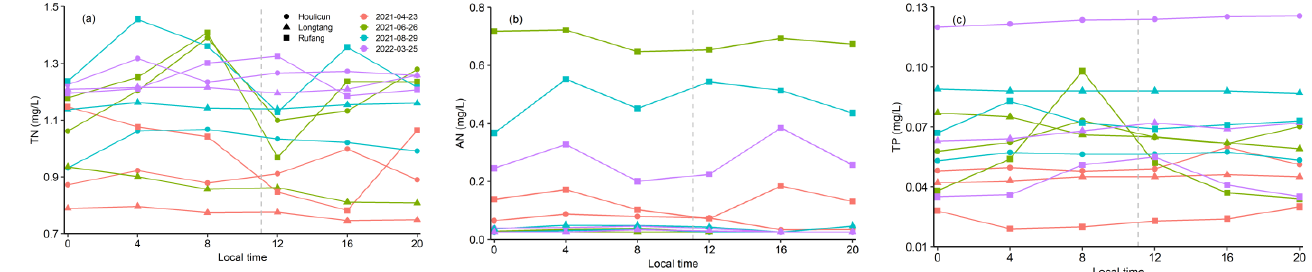
Figure 8. Diurnal cycle of TN ( a ), AN ( b ), and TP ( c ) measured at national cross-sections. Vertical dashed lines at 11:05 represent the Landsat 8 scene center time in the